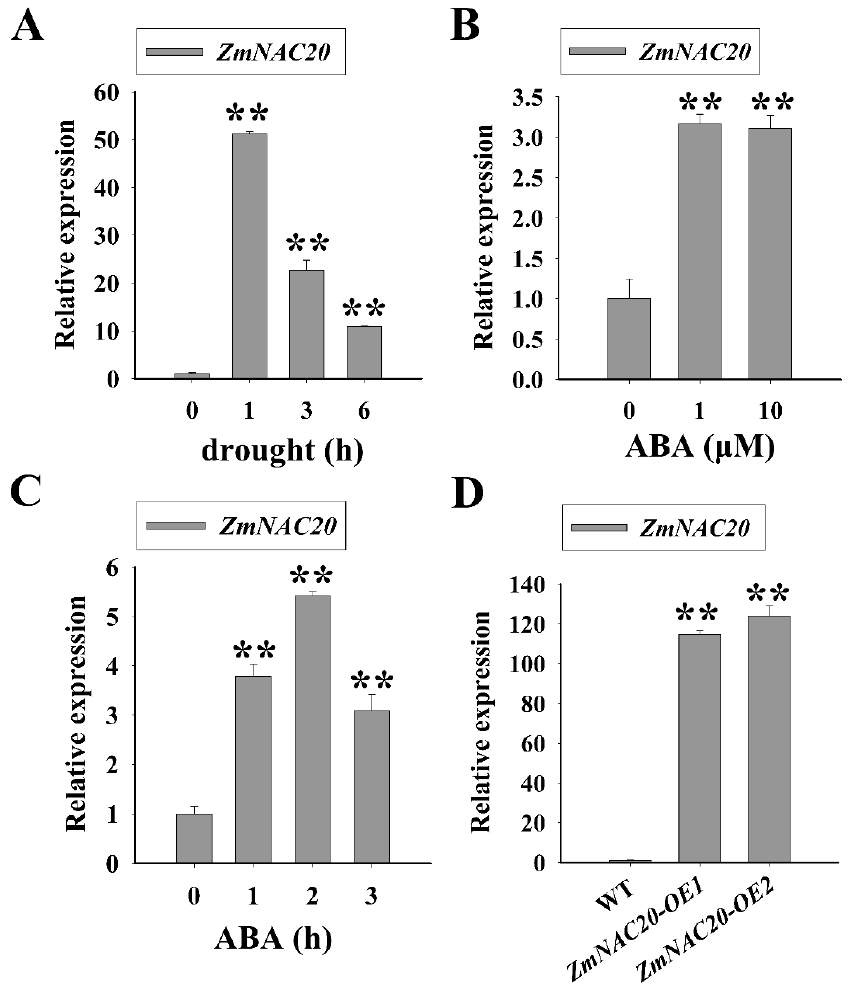
Figure 1. Expression of ZmNAC20 in response to drought stress and ABA. ( A ) The relative expression level of ZmNAC20 in response to drought stress. ( B ) The relative expression level of ZmNAC20 after treatment with different concentrations of ABA. ( C ) The relative expression level of ZmNAC20 after treatment with 1 µ M ABA for 0, 1, 2, and 3 h. ( D ) Relative expression of ZmNAC20 in ZmNAC20 - overexpressing transgenic plants. Asterisks indicate significant differences: ** p < 0.01 (Student’s t